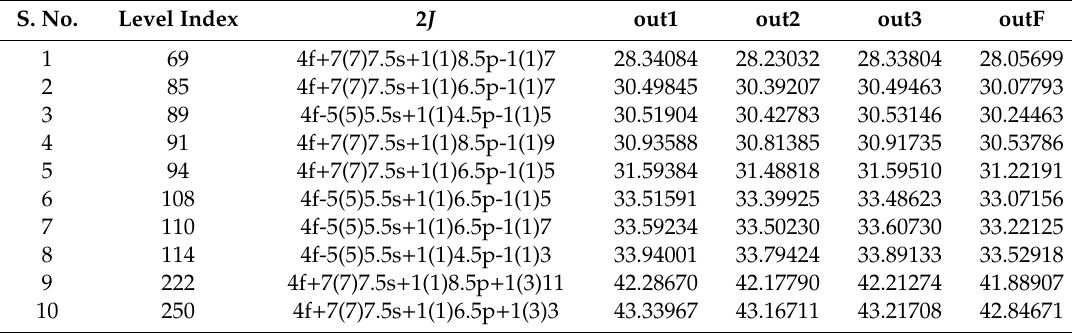
Table 9. Energy values (in eV) from each input for the 4f 13 5s5p configuration of Pm-like W. S.